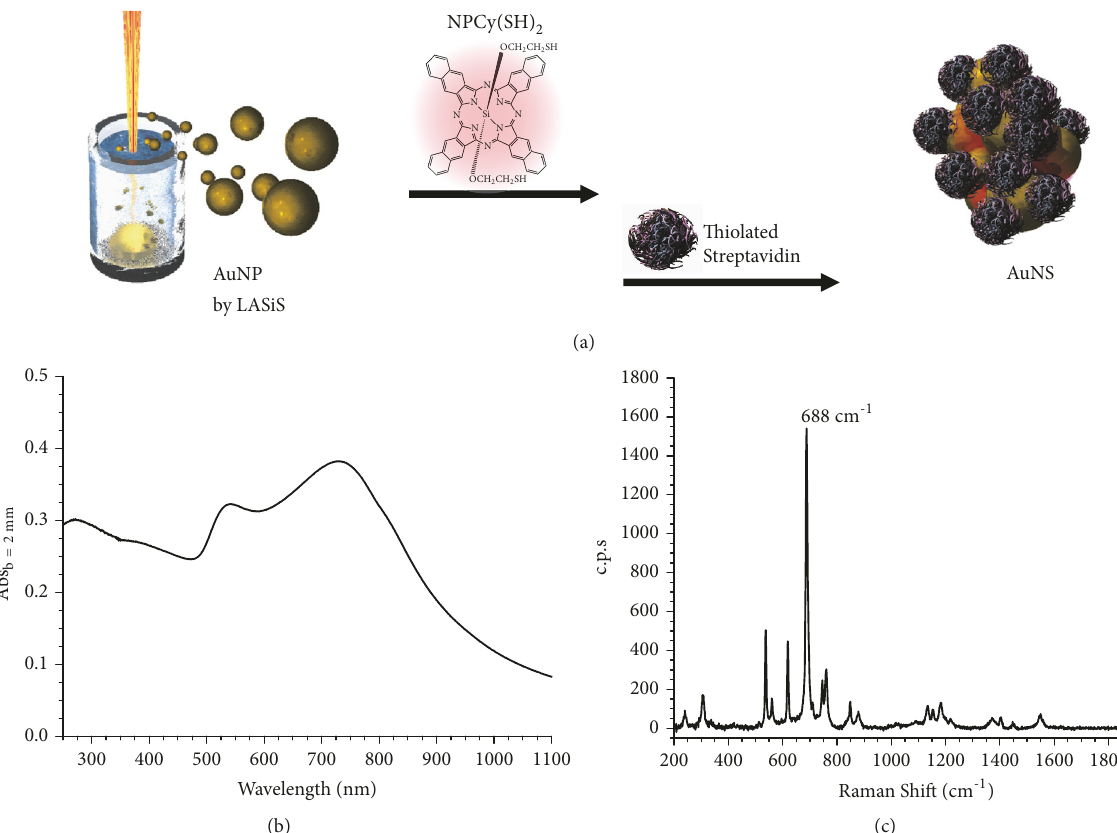
Figure5:(a)CartoonrepresentingthesynthesisofAuNS,fromthelaserablationtothefunctionalizationwiththeSERSreporter,NPCy(SH 2 ), and streptavidin. ((b) and (c)) UV-vis-NIR and SERS spectra of the functionalized AuNS, respectively.